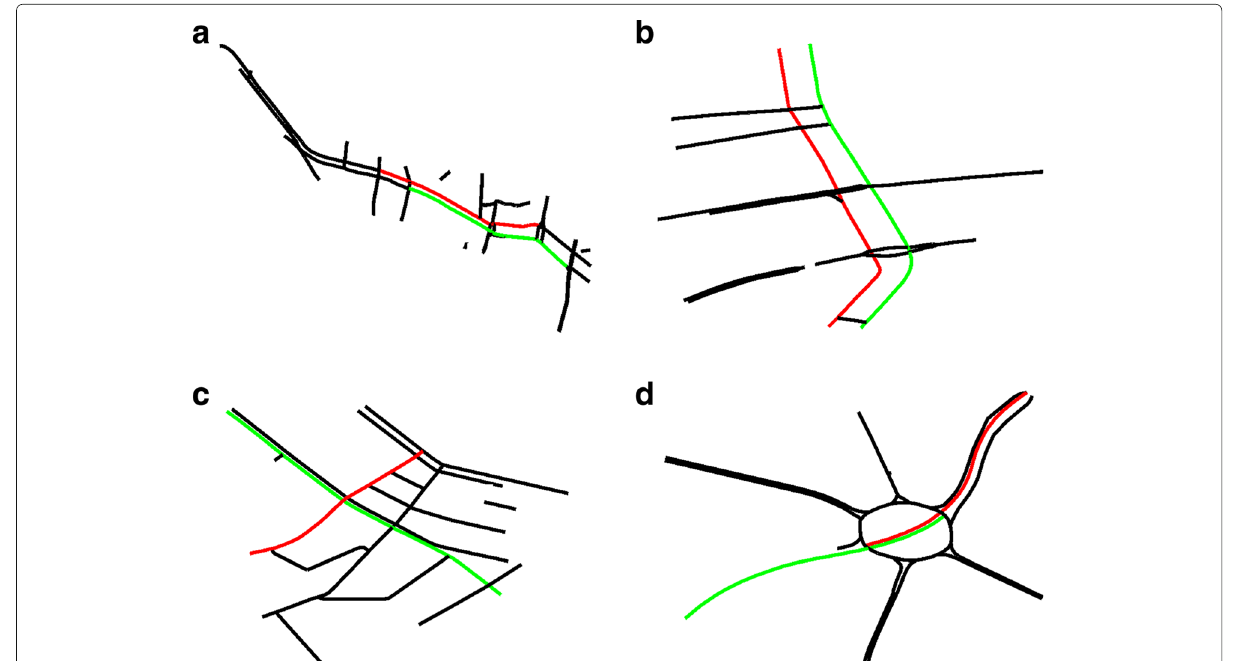
Fig. 7 Routes considered in the four settings. First route in red, second route in green. a Hietzing b WBH c Ring d